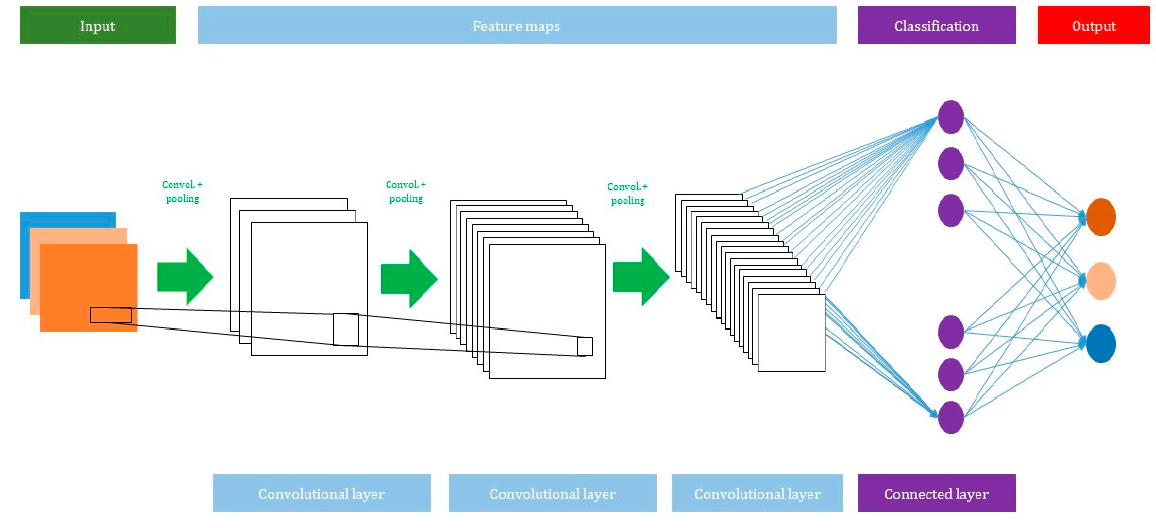
Figure 3. A schematic view of the CNN model.